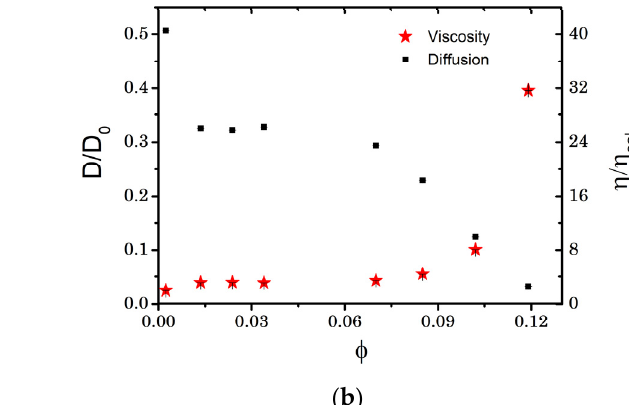
Figure 1. Structure factor, self-diffusion, and viscosity of ferrofluid. ( a ) Depicts the comparison between experimental structure factor S ( k ) from Cousin, F. et al. [12] and rescaled mean spherical approximation liquid theory as a function of wave number k . ( b ) The theoretical fit of S ( k ) was used to determine the self-diffusion coefficient D / D 0 (black square) of Equation (1), and viscosity η / η sol (star symbol) of Equation (2), including experimental hydrodynamic interactions among particles of hard polystyrene spheres from Van Megen, W. et al. [8]. Ref. [12] adapted with permission. Copyright 2022 by the American Physical Society. Ref. [8] adapted with permission. Copyright 2022 by Royal Society of Chemistry. In Figure 1b, error bars are less than the symbol sizes.